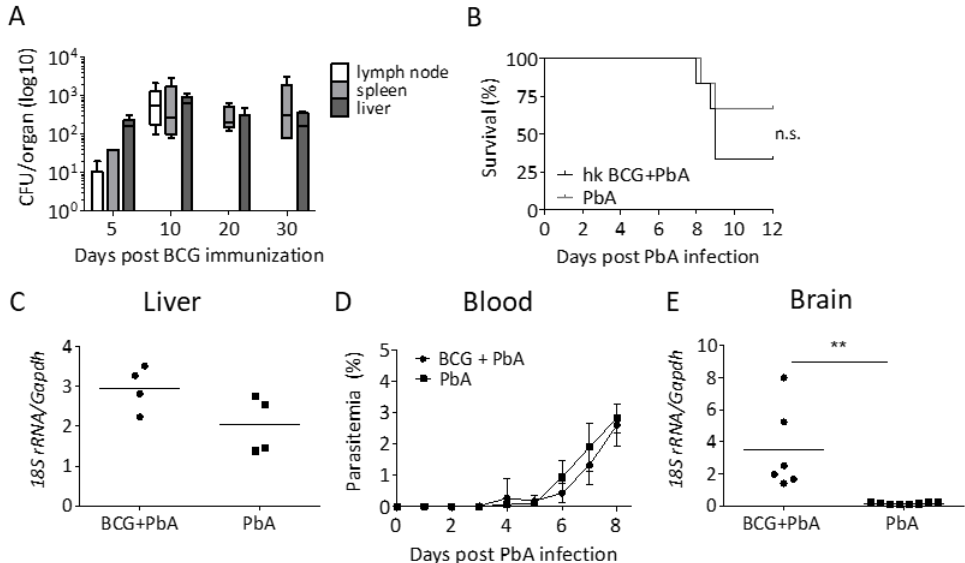
Figure 2. Bacterial and parasitic load. ( A ) Mice were immunized s.c. with 10 7 BCG and at the indicated times, CFU was determined in lymph nodes, spleen, and liver (n = 5). ( B ) ECM-free survival in mice that were immunized with heat-killed (hk) BCG or left untreated and challenged with 10 4 PbA SPZ i.v. 30 days later (n = 6; log-rank test; n.s. = not significant). ( C – E ) Naive mice or mice that had been vaccinated with BCG 30 days before were infected with PbA SPZ. Liver load was determined 42 h after PbA infection ( C ). Data from one out of two independent experiments are shown; symbols and bars represent individual mice and means, respectively. ( D ) Parasitemia was determined on Giemsa-stained blood smears from tail blood. Data are shown as mean ± SD from one representative experiment out of three; n = 6. ( E ) Parasite load in brains of mice that succumbed to ECM and those that were protected by BCG immunization (data from one out of two independent experiments are shown; symbols and bars represent individual mice and means, respectively). Statistical analysis was performed by Student’s t -test; ** p < 0.01.